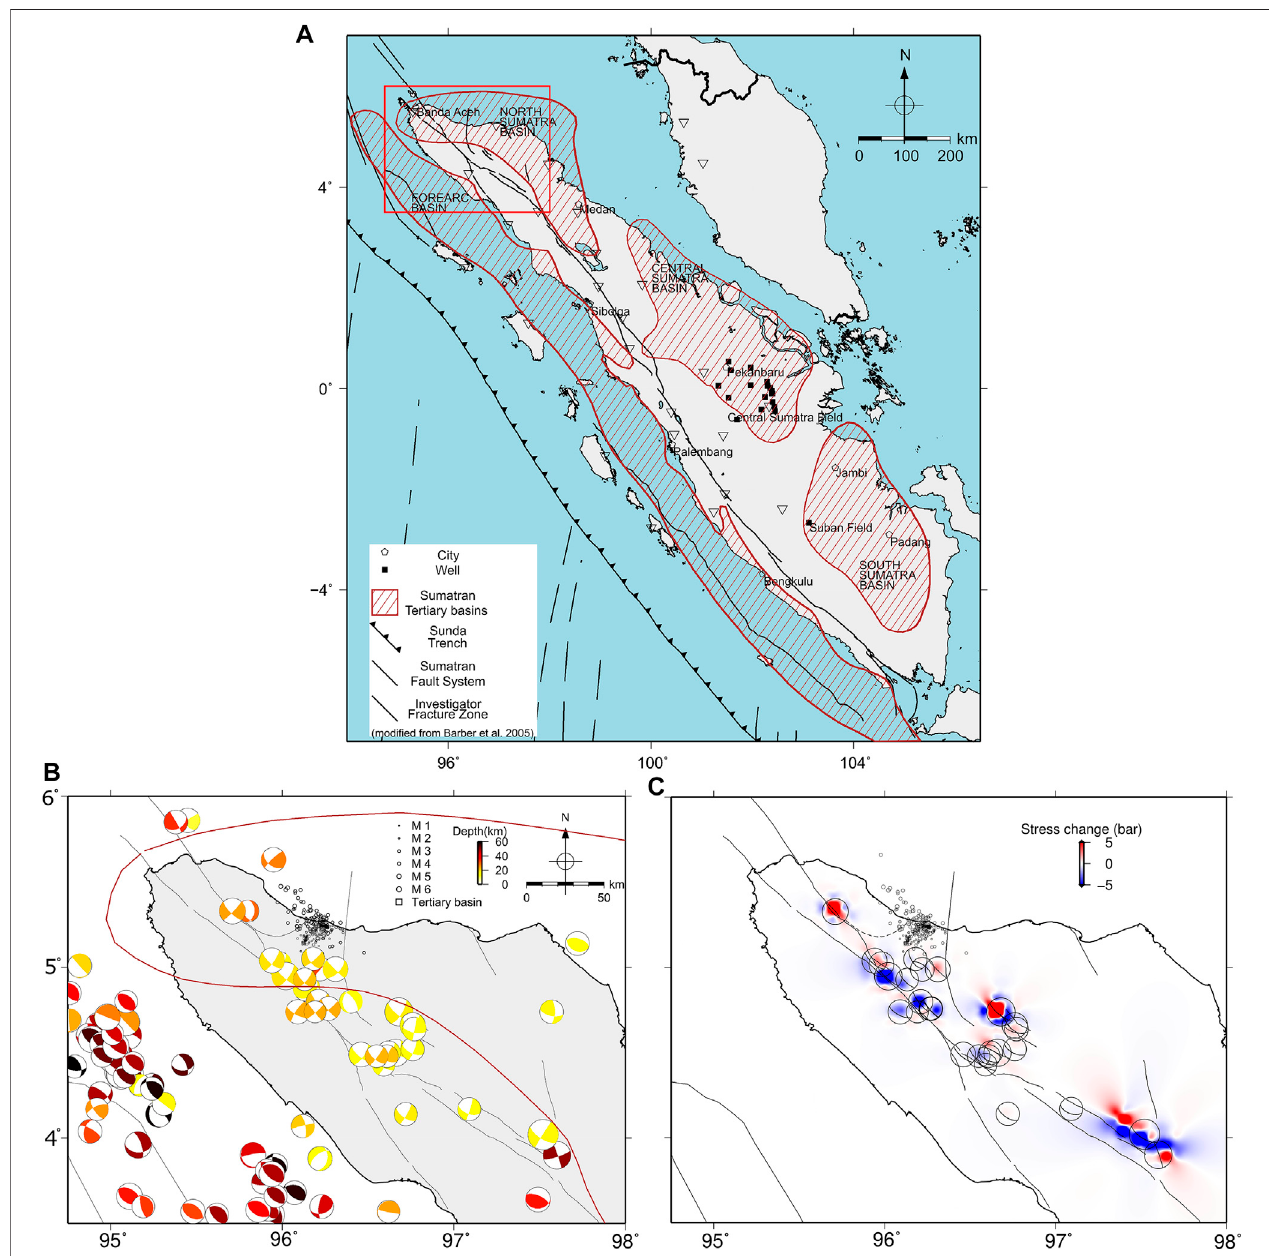
FIGURE 3 | (A) Sumatra tectonic setting (modi fi ed from Barber et al. (2005)), well fi eld location (Mount and Suppe, 1992; Hennings et al., 2012), regional station networks (open triangle), and research area (red square). (B) GCMT events from June 1976 until the M6.5 Pidie Jaya 2016 earthquake. (C) Δ CFS resolved on Panteraja structure. Depth 20 km, μ 0.4. The transparent focal mechanisms showing the selected nodal plane, used as Δ CFS source faults.